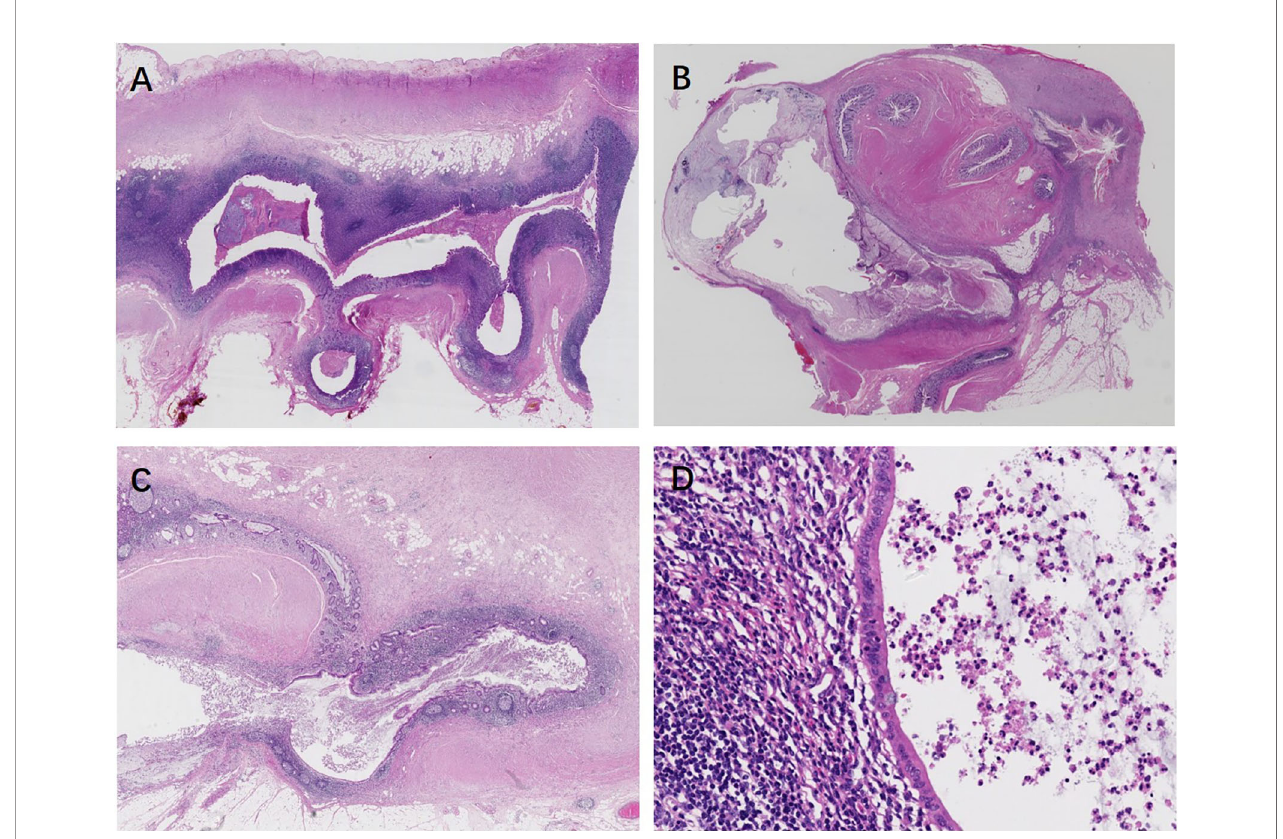
FIGURE 4 | Appendiceal diverticulosis disease. (A) Multiple intact diverticula herniate through the muscularis propria. (B – D) Ruptured appendiceal diverticula. (B) Multiple ruptured diverticula lead to tip deformation and subserosal mucus cyst formation. (C) A ruptured appendiceal diverticulum is lined with mucosa preserved of the relatively normal lamina propria, but there is an epithelial monolayer in the area below the picture. Mucin deposit in the mesoappendix. (D) At higher magni fi cation, atrophy mucosa lined with a monolayer epithelium shows a lack of mucin and nuclear abnormalities, and there are abundant lymphoid follicles in the underlying lamina